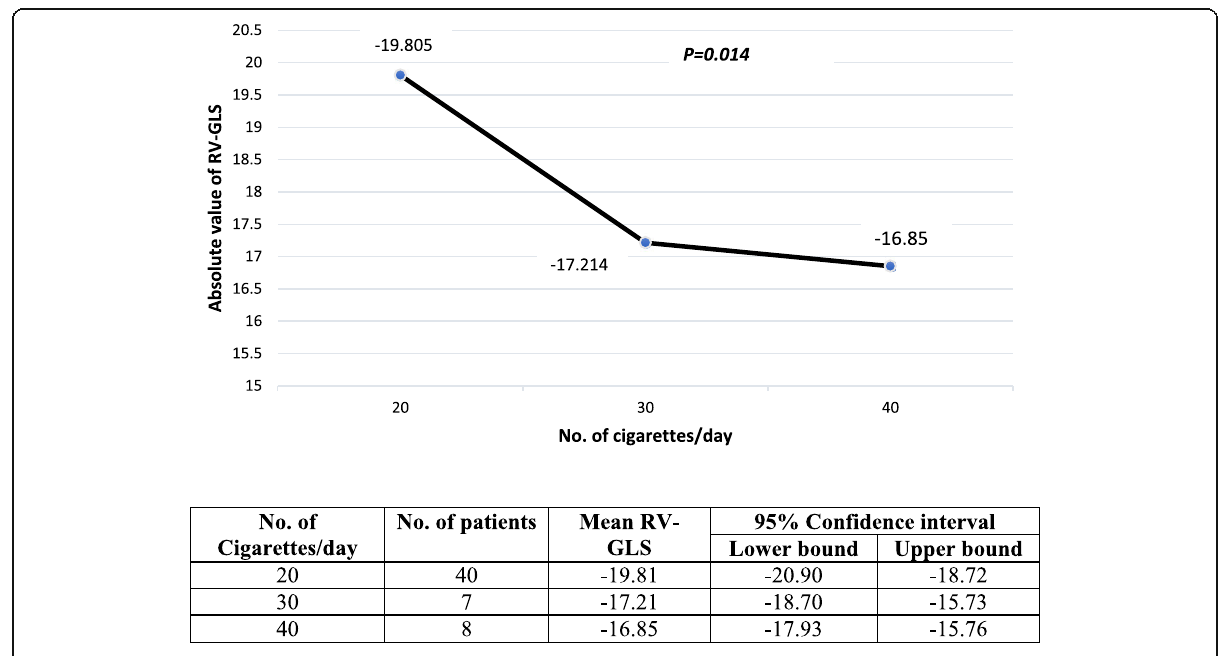
Fig. 2 Means of RV GLS according to the number of consumed cigarettes per